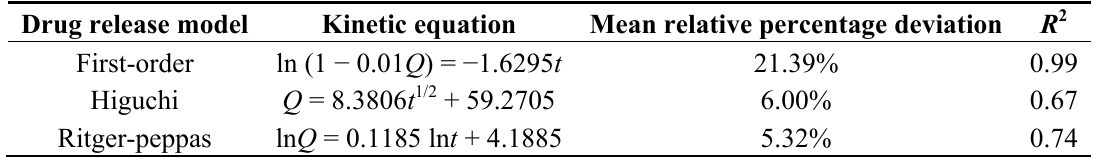
Table 3. Release Kinetics of Formulation.